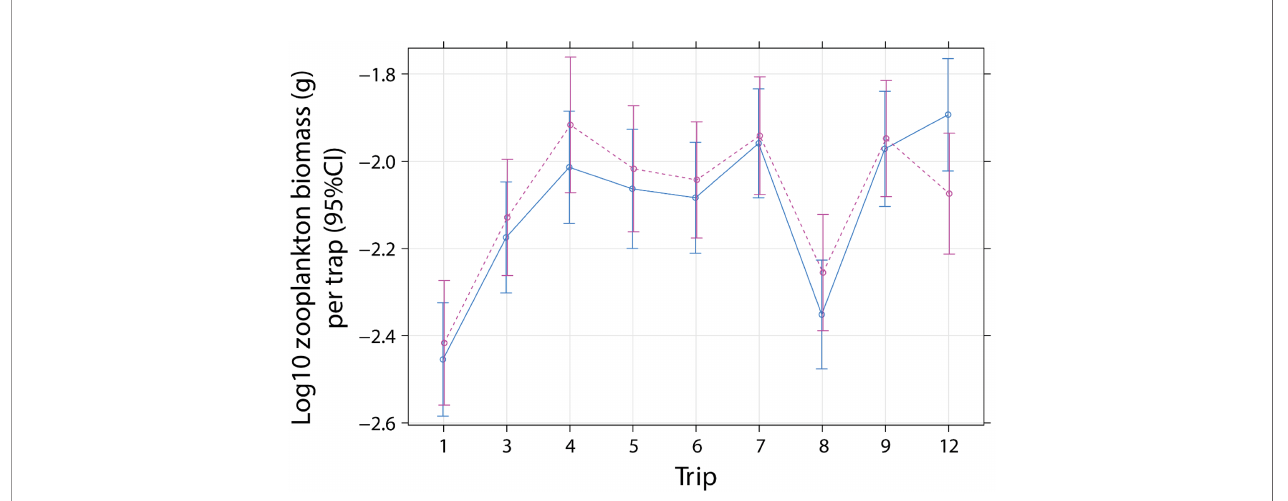
FIGURE 2 | Effect plot for mean zooplankton biomass per emergence trap (1 m -2 ) for cleaner fi sh Labroides dimidiatus presence treatment [Control = yes cleaner fi sh present (solid line)], Removal = no cleaners present [dashed line] and sampling trip (1 = July 2000, 3 = September 2000, 4 = November 2000, 5 = January 2001*, 6 = August 2001, 7 = January 2002*, 8 = June 2002*, 9 = January 2003*, 12 = December 2012). *P < 0.05 for time of day and trip interaction, relative to trip